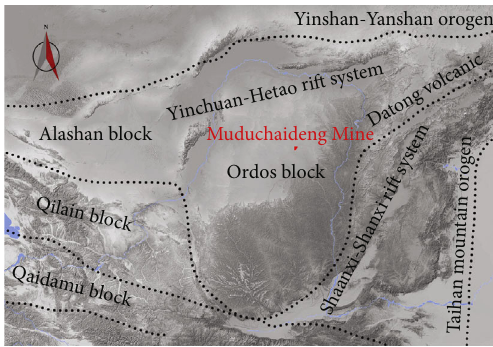
Figure 1: Ordos block periphery tectonic distribution